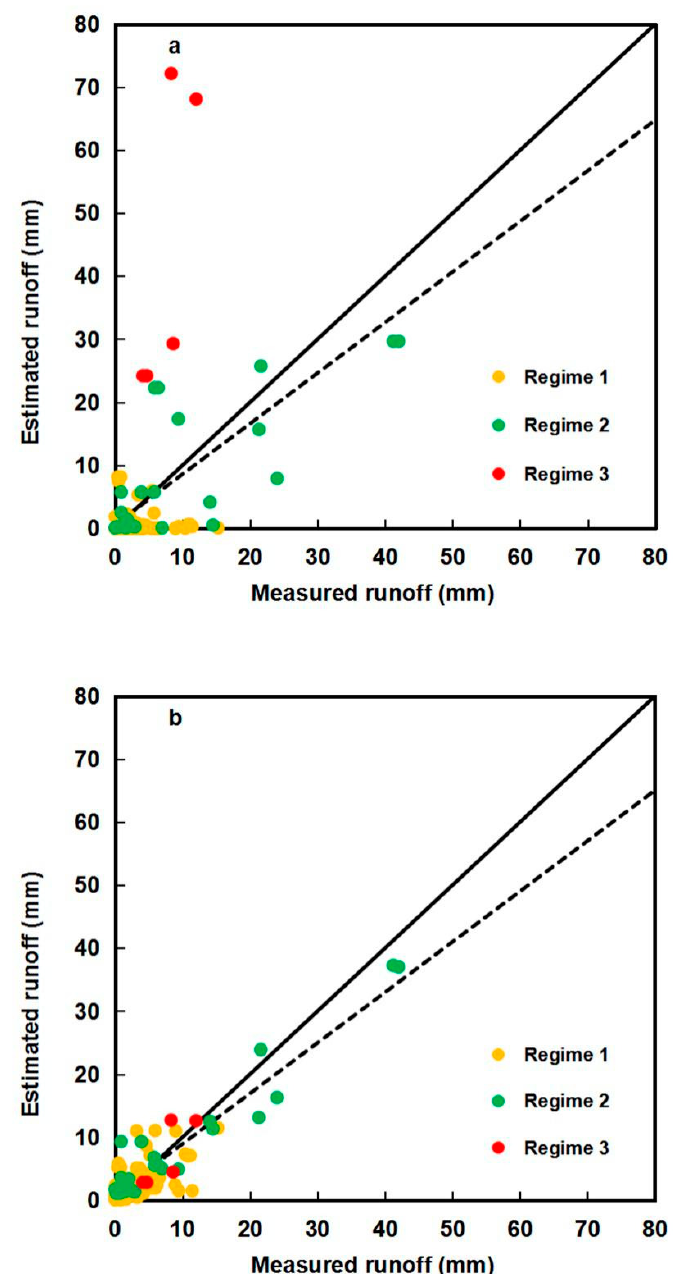
Figure 8. Measured versus estimated runoff depths for ( a ) the original SCS-CN method and ( b ) Method 2 of the three rainfall